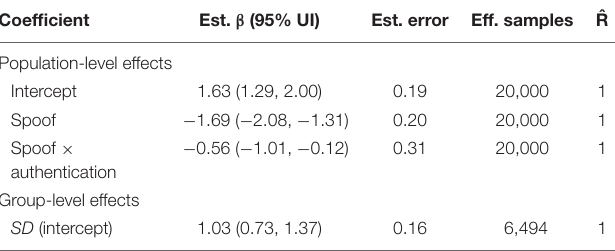
TABLE 4 | Real-time measures model coefficients with credible effects different than